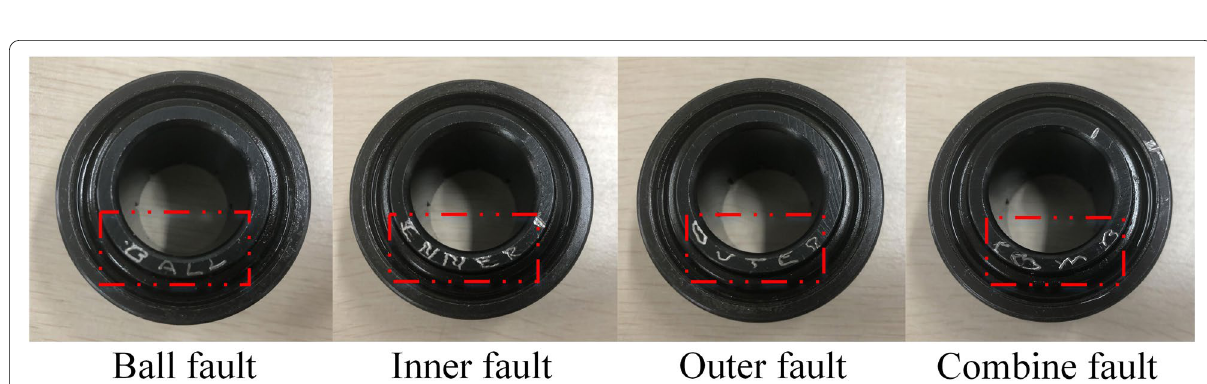
Fig. 6 Bearing fault states. The letters marked in the red box indicate the fault type of each